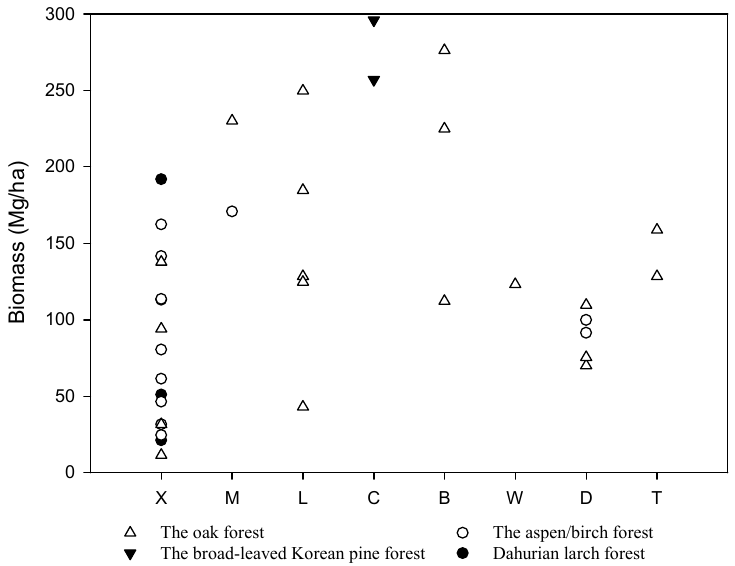
Figure 3. Estimated biomass of the main temperate forests in China. The studies along the x-axis are organized from north to south as follows, X: Xiaoxing’an Mountains [41]; M: Maor Mountain [46]; L: Laoyeling Mountain [47]; C: Changbai Mountain [38,39]; B: Bingla Moutain [48]; W: Wuling Mountain [49]; D: Dongling Moutain ([34], this study); T: Baotianman [50,51].